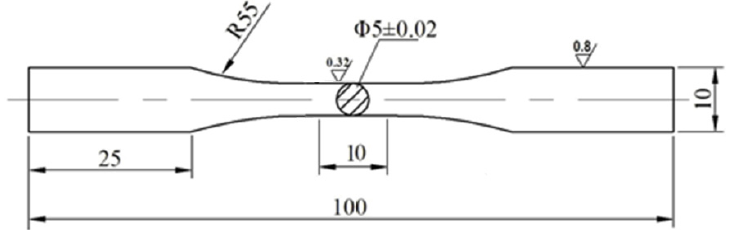
Figure 1. Geometry of LCF specimen (unit in mm).